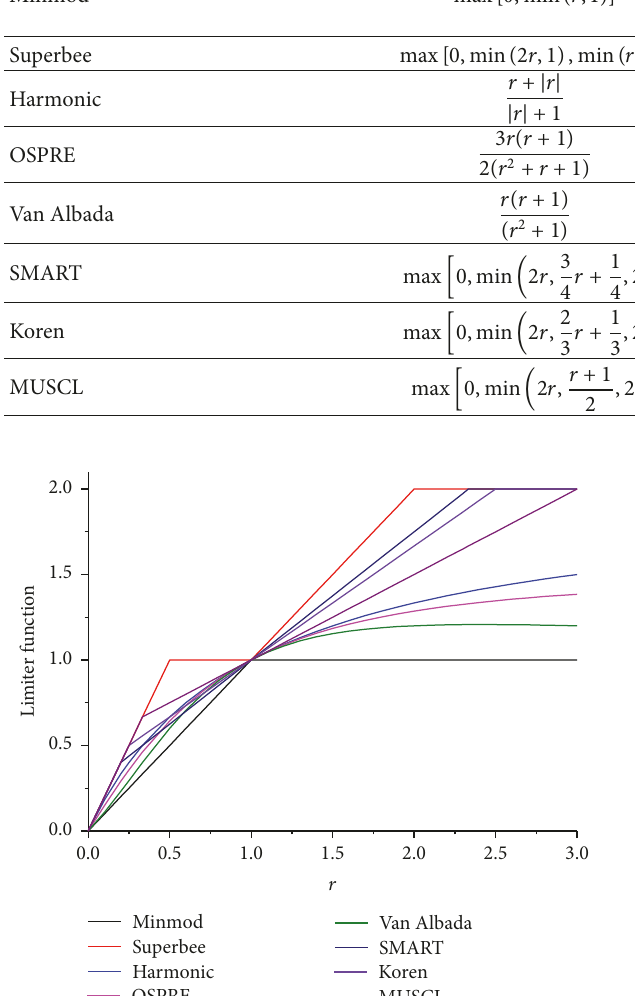
Figure 2: Nonlinear flux limiter